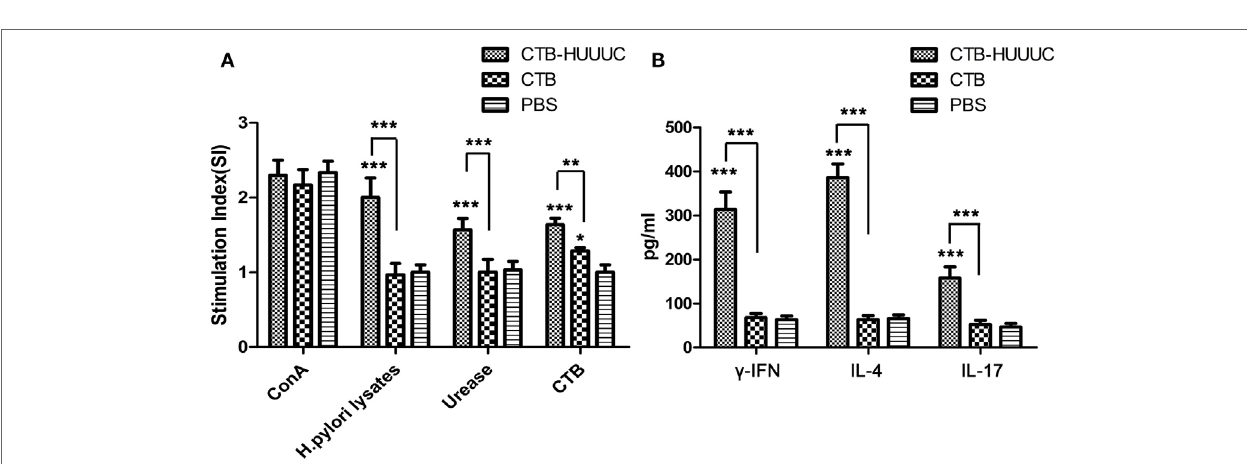
FigUre 4 | Helicobacter pylori -specific lymphocyte responses and IFN- γ , interleukin-4 (IL-4), and interleukin-17 (IL-17) production in mice immunized with cholera toxin B subunit (CTB)-HUUC or CTB. (a) Assessment on proliferation of specific lymphocytes in mice after immunization with CTB-HUUC, CTB, or PBS. Splenic lymphocytes from mice immunized with CTB-HUUC, CTB, or PBS were stimulated with Concanavalin A (ConA), H. pylori lysates, H. pylori urease, or CTB. Cell proliferation was determined using CCK-8 assay. The results were expressed as stimulation indices (SI) which represents the ratio between the proliferation rates of cells stimulated with antigens and those with the vehicle control. * p < 0.05, ** p < 0.01, and *** p < 0.001, compared with the PBS group or between the CTB-HUUC and CTB groups. (B) The concentrations of IFN- γ , IL-4, and IL-17 in the supernatants of lymphocytes cultures. Splenic lymphocytes from mice immunized with CTB-HUUC, CTB, or PBS were stimulated with H. pylori lysates and the supernatants were collected for determination of IFN- γ , IL-4, and IL-17 concentrations by ELISA. *** p < 0.001, compared with the PBS group or between the CTB-HUUC and CTB